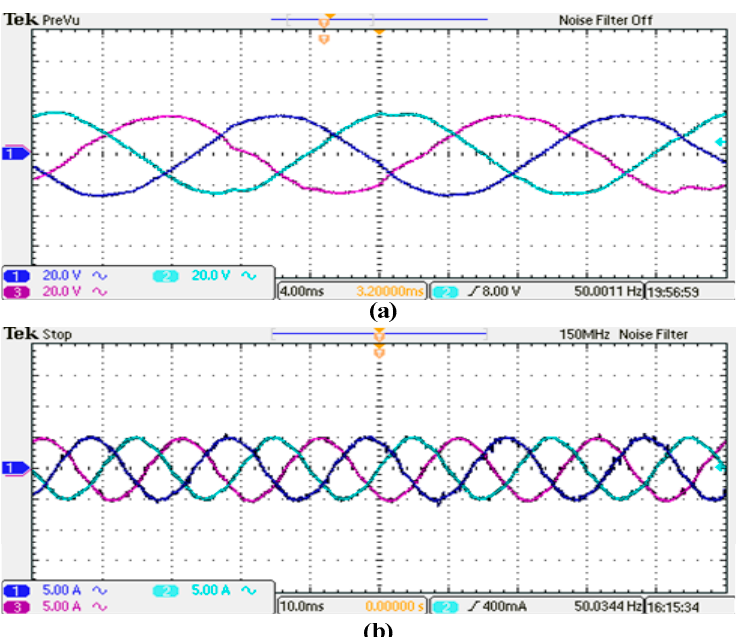
Figure 28. DFIG system in weak grid with high bandwidth Lead / Lag PLL ( a ) Stator voltage, and ( b ) Stator current.